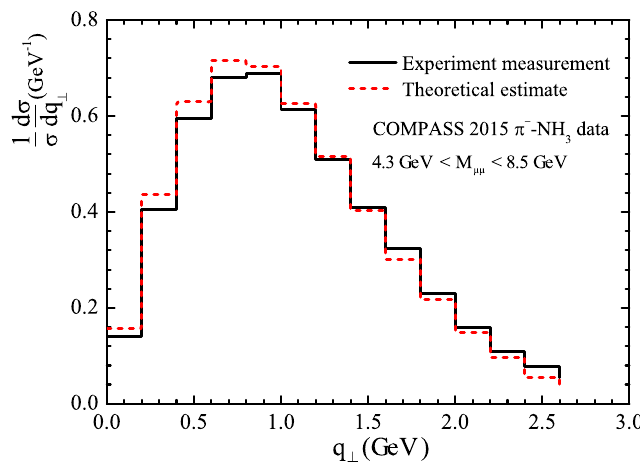
Figure 3 . The transverse spectrum of lepton pair production in the unpolarized pion-nucleon Drell- Yan process, with an NH 3 target at COMPASS. The dashed line is our theoretical calculation using the extracted Sudakov form factor for the pion TMD PDF. The solid line shows the experimental measurement at